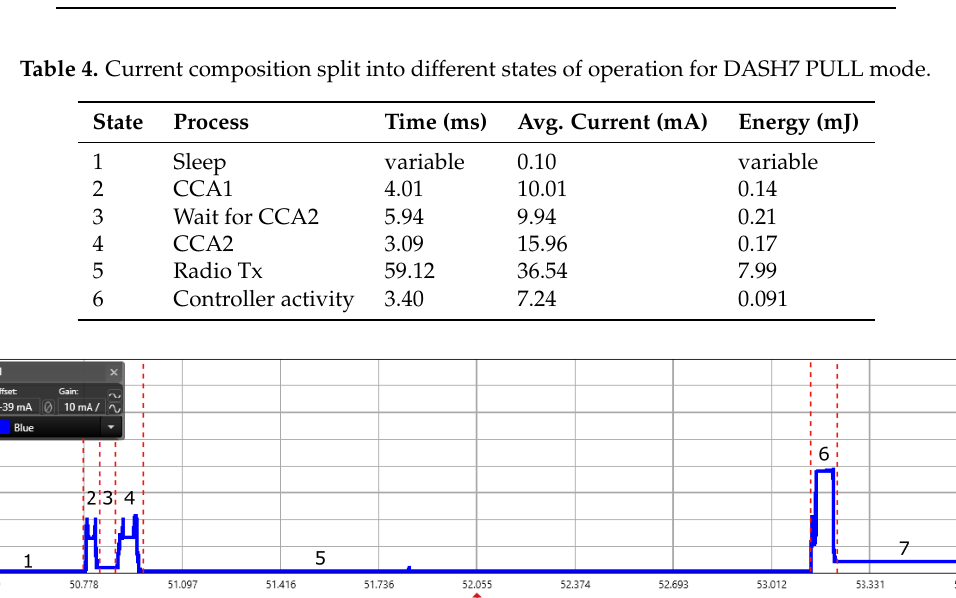
Figure 13. Scope view of a DASH7 PULL mode with background frame, foreground frame and data transmission captured using power analyzer for the measurement of energy consumption.